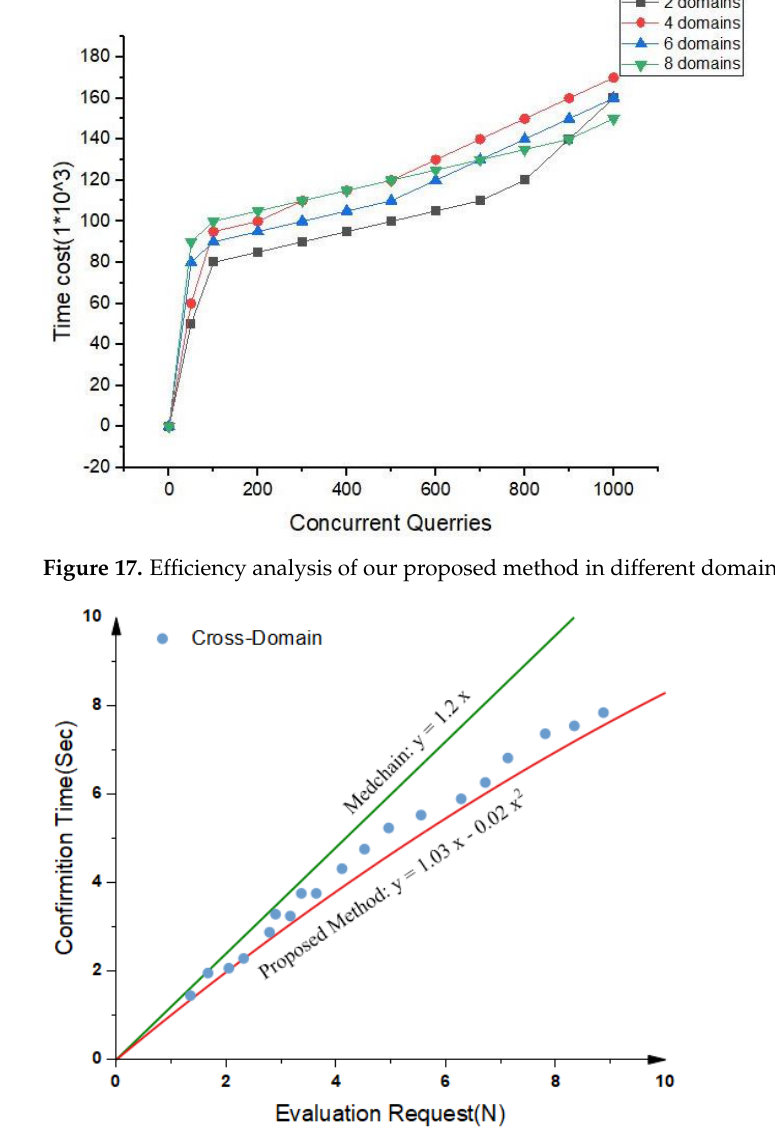
Figure 18. Comparative analysis of the cross-domain module used in our proposed